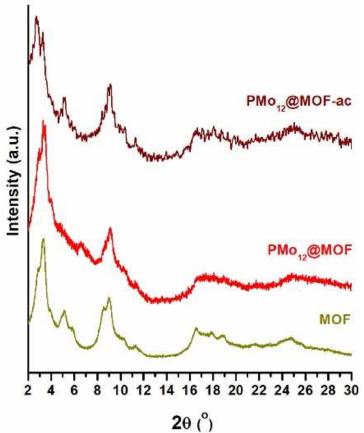
Figure 2. Powder XRD patterns of NH 2 -MIL-101(Cr) (MOF) and the corresponding PMo 12 @MOF composite before and after catalysis (ac).